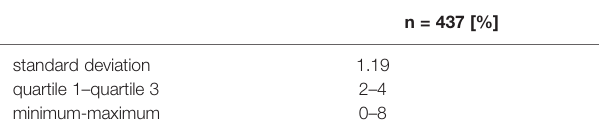
TABLE 3 | Durvalumab eligibility according to PACIFIC criteria.